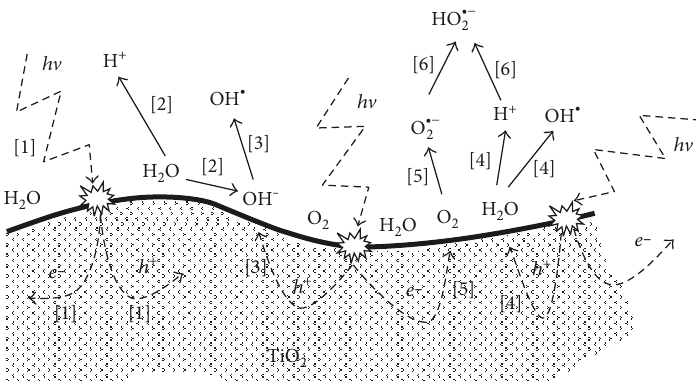
Figure 1: Chemical activation of TiO (cid:129) ), and superoxide anion (O radical (HO 2 potential to decompose or mineralize a wide range of com- pounds [12 – 14].